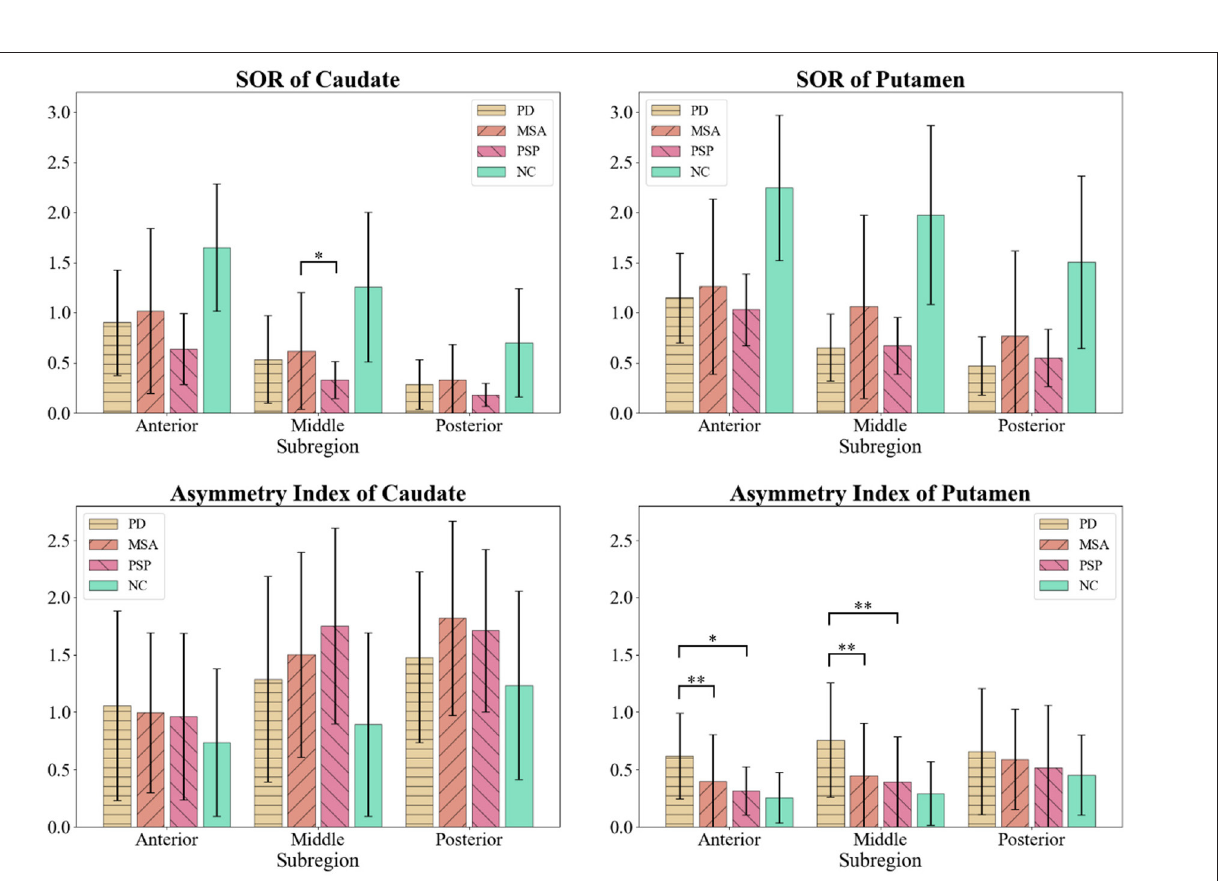
FIGURE 2 | Comparison of SOR values and bilateral asymmetric indexes among parkinsonism groups and normal controls (NC). * p < 0.05; ** p < 0.01. SOR value of middle caudate was lower in PSP group than MSA group. Asymmetric indexes of anterior and middle putamen were elevated in PD group compared with all other